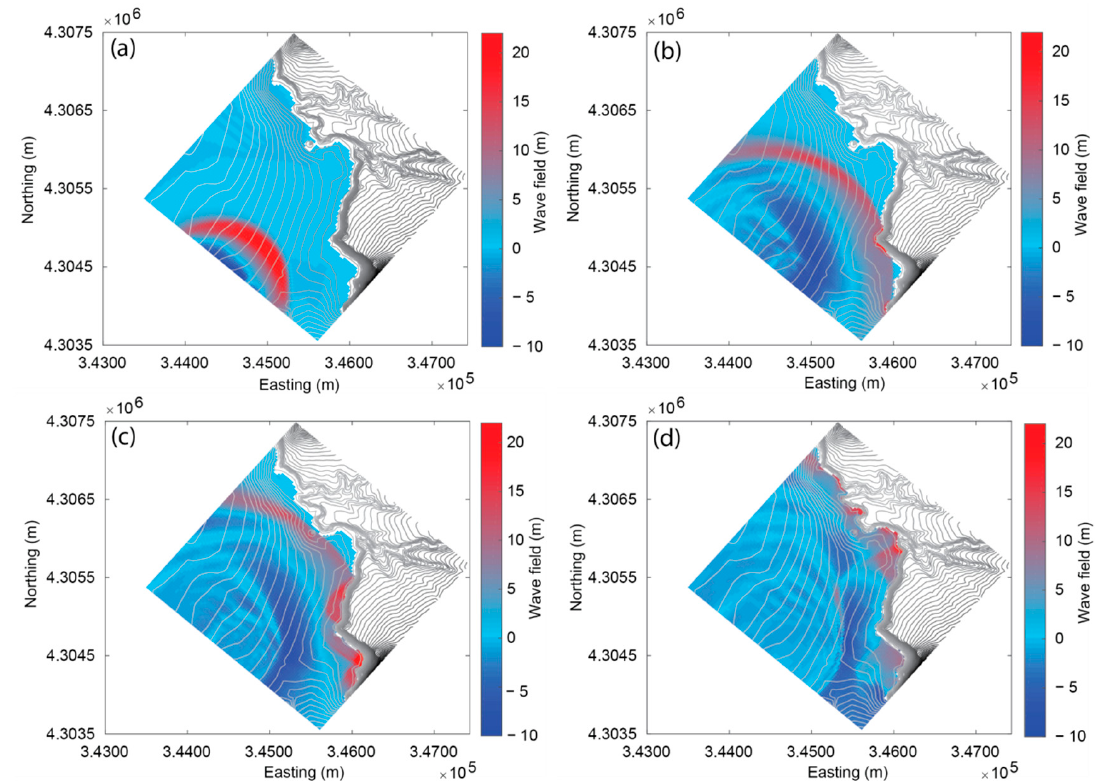
Figure 9. Time history of wave propagation in scenario 1 at ( a ) t = 33 s, ( b ) 66 s, ( c ) 96 s, and ( d ) 122 s.